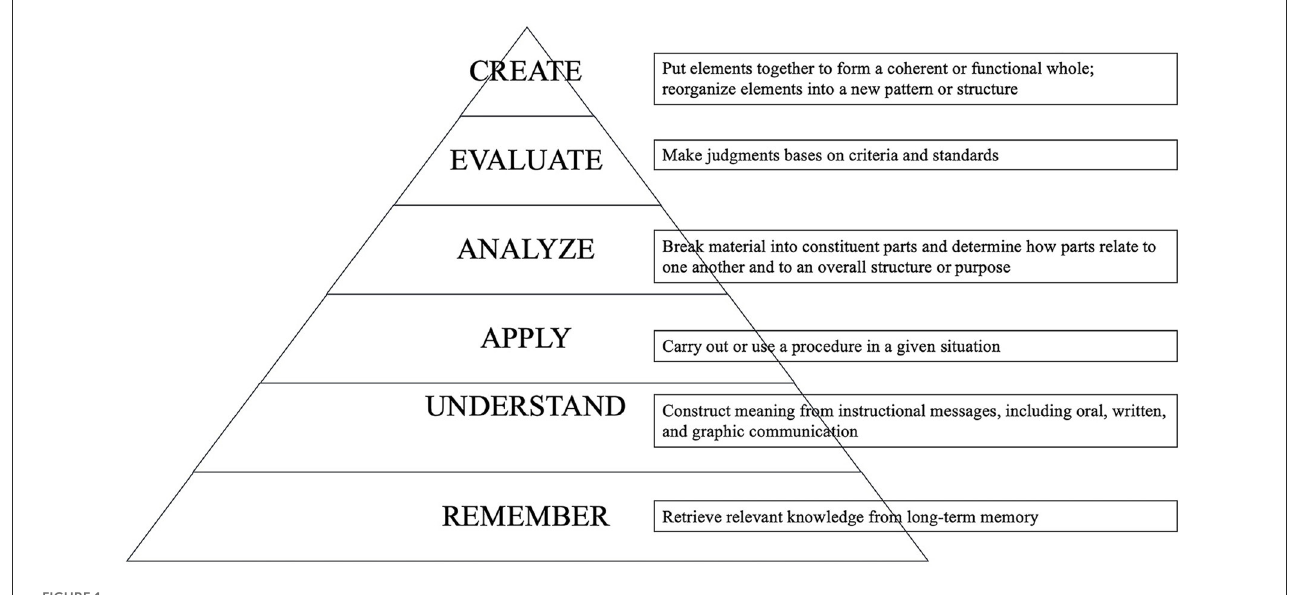
FIGURE1 Bloom’s taxonomy in cognitive